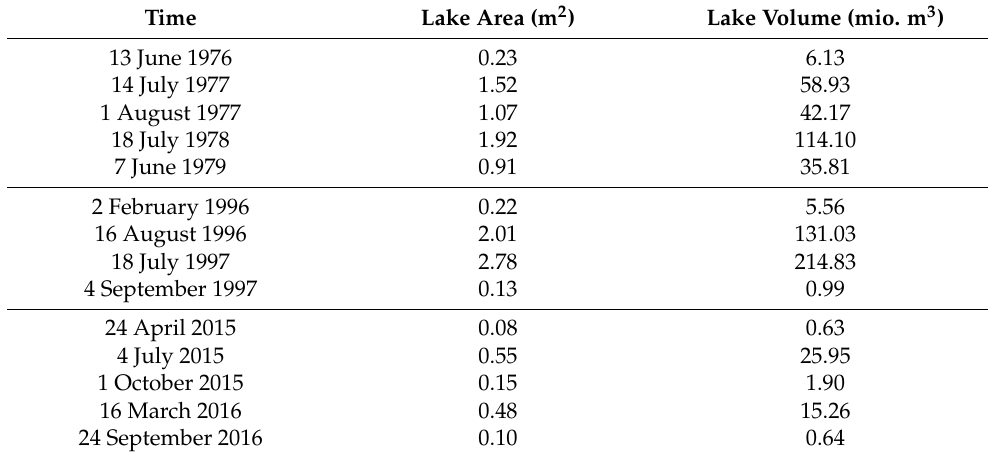
Table 3. Glacial lake area and volume change.